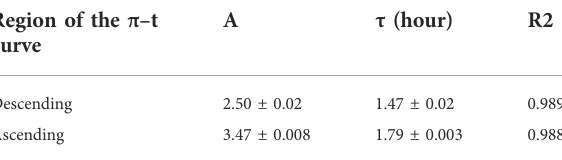
TABLE 1 Fitted Parameters of the ( π -t) adsorption kinetics of HC-Ct DNA molecules using Eqs 1, 2. Region of the π – t